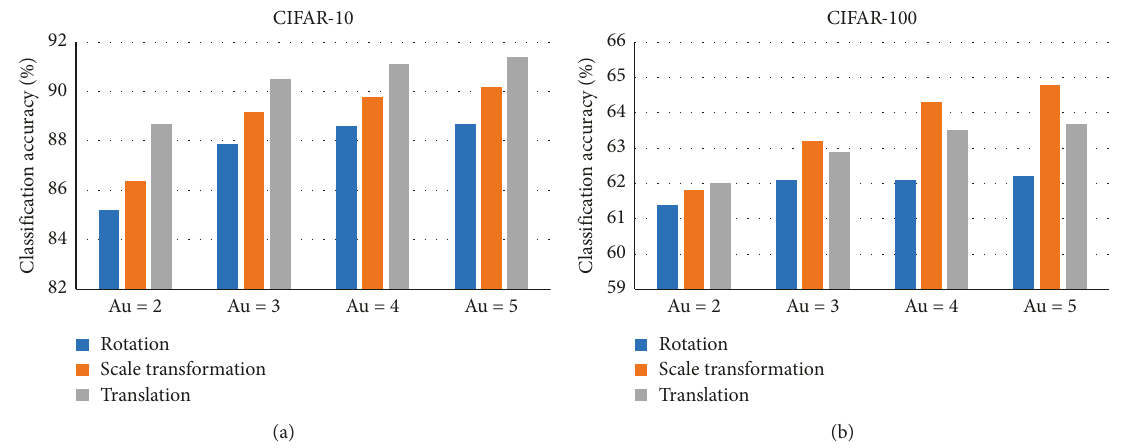
Figure 7: The relationship between the expanded sample size and network generalization ability, in which the number of images is expanded to Au times.